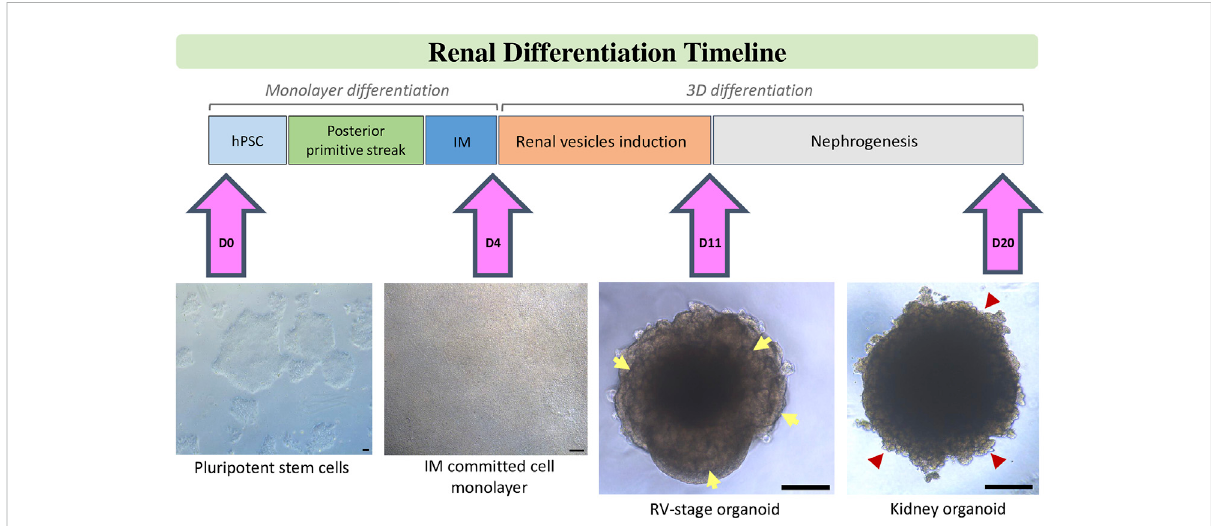
FIGURE 1 Schematic stepwise description of the differentiation of kidney organoids from hPSCs. After treatment of hPSCs with factors and small molecules according to chosen protocol posterior primitive streak is induced. Further treatment with renal inductive signals leads to intermediate mesoderm (IM) commitment. Speci fi cally, in our protocol, this step is characterized by the formation of a tight monolayer of IM committed cells on Day 4 of differentiation. IM-comitted cells are treated with a short pulse of CHIR, then aggregated to spheroids and further stimulated with FGF9 signalling until Day 11 to induce the formation of renal vesicels (RVs), which are visible at the borders of the organoid (yellow arrows). Upon removal of factors, RVs develop into tubular and glomerular structures (red arrow heads) to generate kidney organoids by Day 20 of differentiation. Scale bars, 100